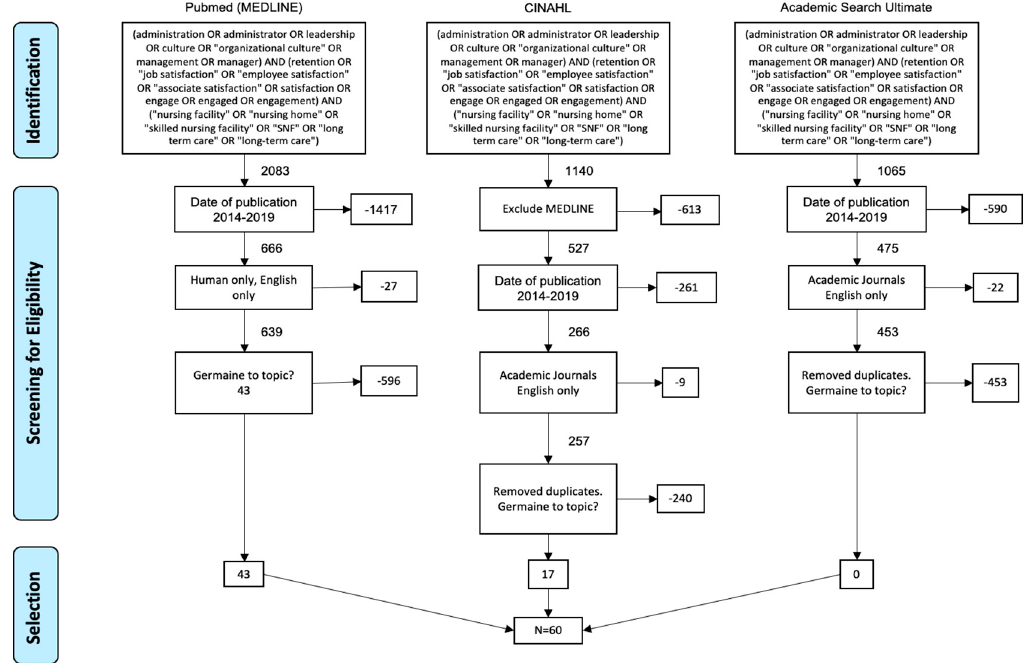
Figure 1. Preferred Reporting Items for Systematic Reviews and Meta-Analysis (PRISMA) Flow Chart.